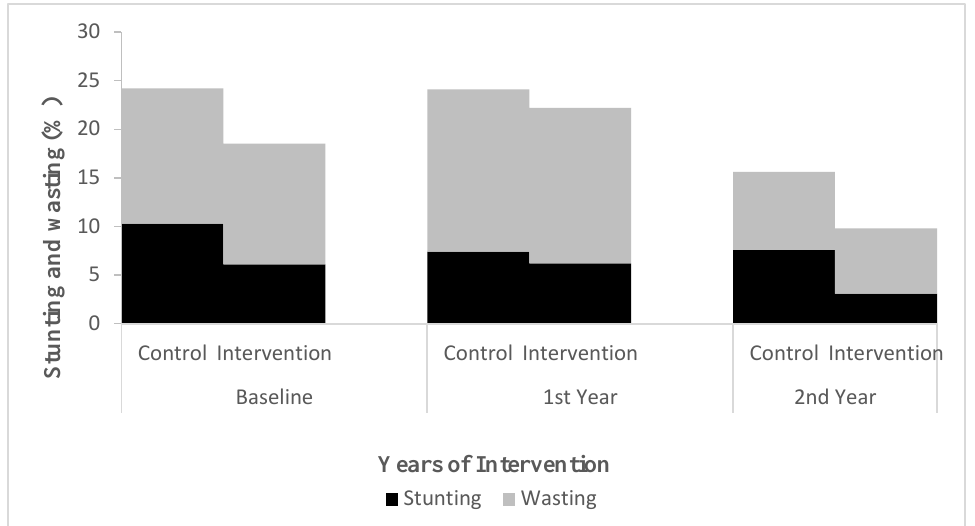
Figure 5. Changes in proportion for children’s stunting and wasting in first and second year from baseline. Multilevel model was used to evaluate the effect of the intervention after adjusting for physical activity. Stunting: group effect, p < 0.05. Wasting: time effect (two years), p < 0.05. Others all p > 0.05.